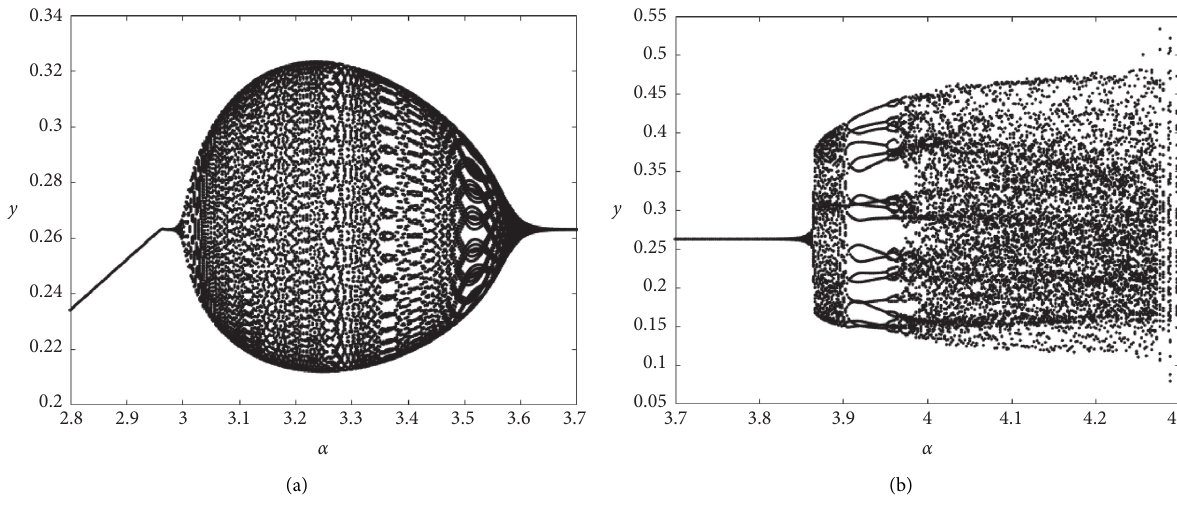
Figure 2: Magnification of part of Figure